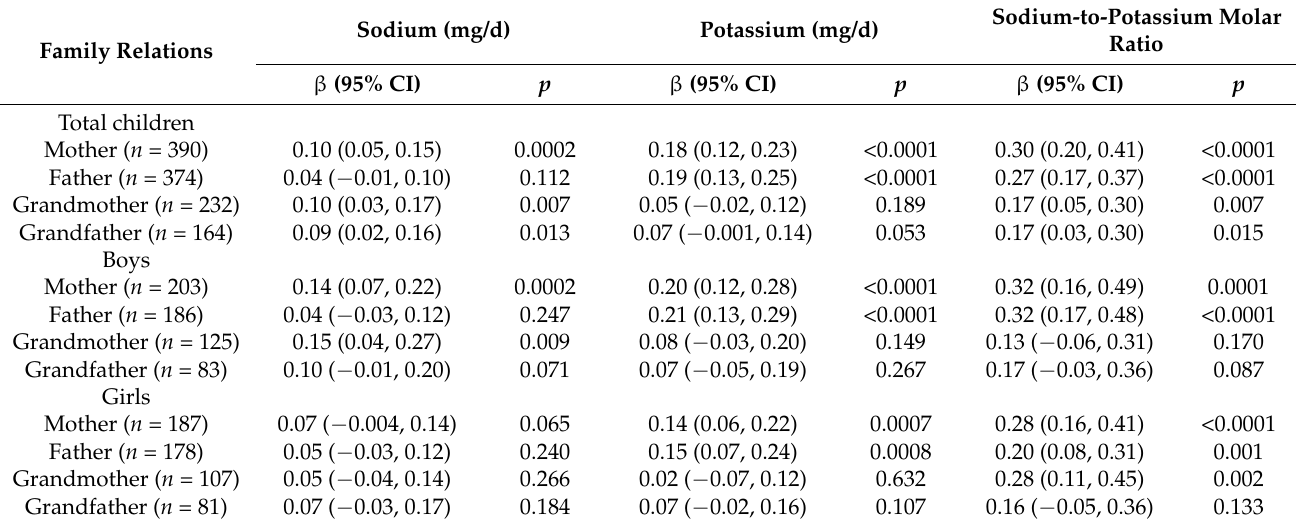
Table 4. Association of sodium, potassium excretion and sodium-to-potassium ratio of children with different family